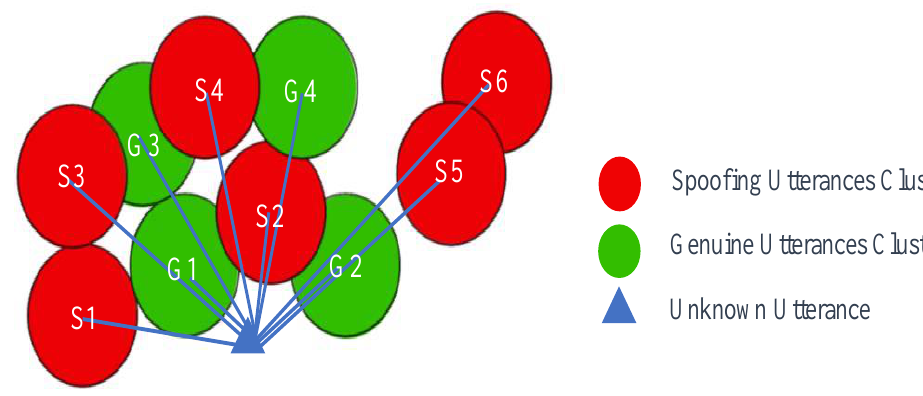
Figure 2. Illustrative example of the spoofing countermeasure based on mining hidden partitions of genuine and spoofed utterances [72].